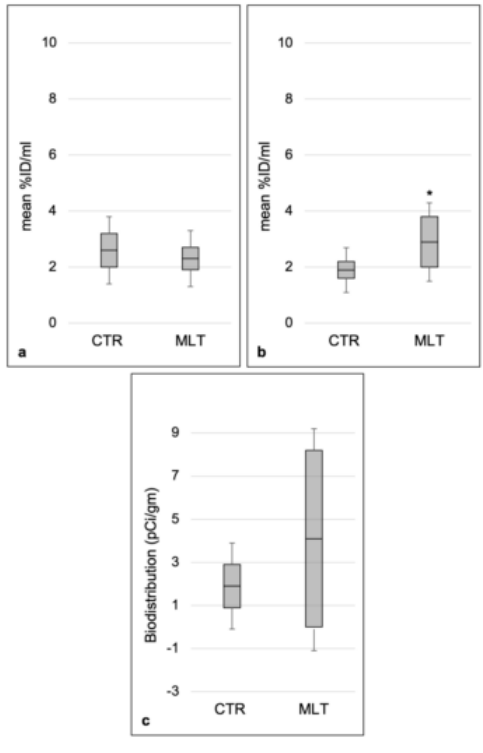
Figure 5. Aortic 18 F-FDG uptake and biodistribution. Results were obtained from scans that were performed on a dedicated small animal PET / CT scanner and are expressed as mean %ID / mL (%injected dose per mL of tissue) from 18 F-FDG PET / CT ( a , b ) and activity concentration (mean pCi / gm) from biodistribution data ( c ). The latter was divided by 10 5 for the purpose of visualization. Error bars represent the 95% confidence interval around the mean; * indicates the level of significance, p ≤ 0.05; CTR control group; MLT, mice treated with melatonin; %ID / mL, % injected dose per mL of tissue; pCi / g, picocurie per